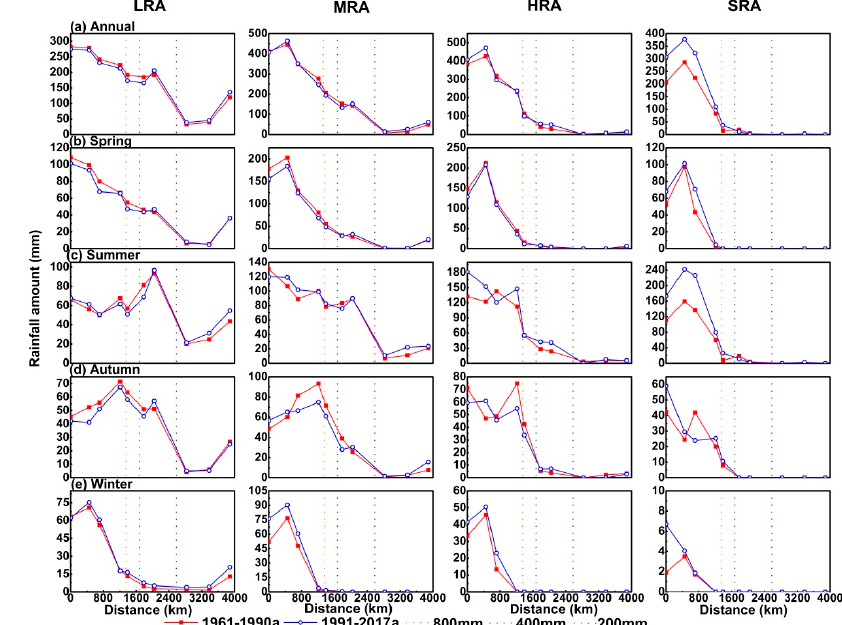
Figure 10. Changes of different grades of precipitation amount with distance from the sea, including light rainfall amount (LRA), moderate rainfall amount (MRA), heavy rainfall amount (HRA), and storm amount (SRA). Different grades of precipitation amount also include annual ( a ) and seasonal (including spring ( b ), summer ( c ), autumn ( d ) and winter ( e )) variations. “800 mm” represents the 800-mm precipitation contour, “400 mm” represents the 400-mm precipitation contour, and “200 mm” represents the 200-mm precipitation contour.